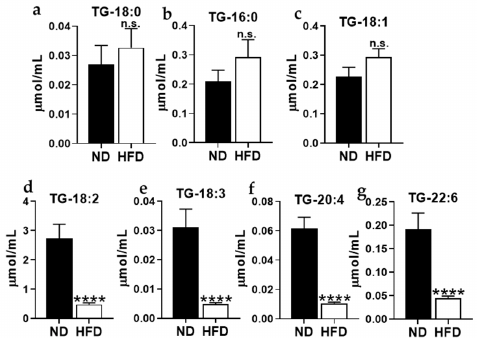
Figure A3. Total levels of plasma ( a ) TG-16:0, ( b ) TG-18:0, ( c ) TG-18:1, ( d ) TG-18:2, ( e ) TG-18:3, ( f ) TG-20:4 and ( g ) TG-22:6. Data are expressed as means ± SEM, **** p < 0.0001, n.s = not significant. Asterisks indicate significant di ff erence compared to the matched ND